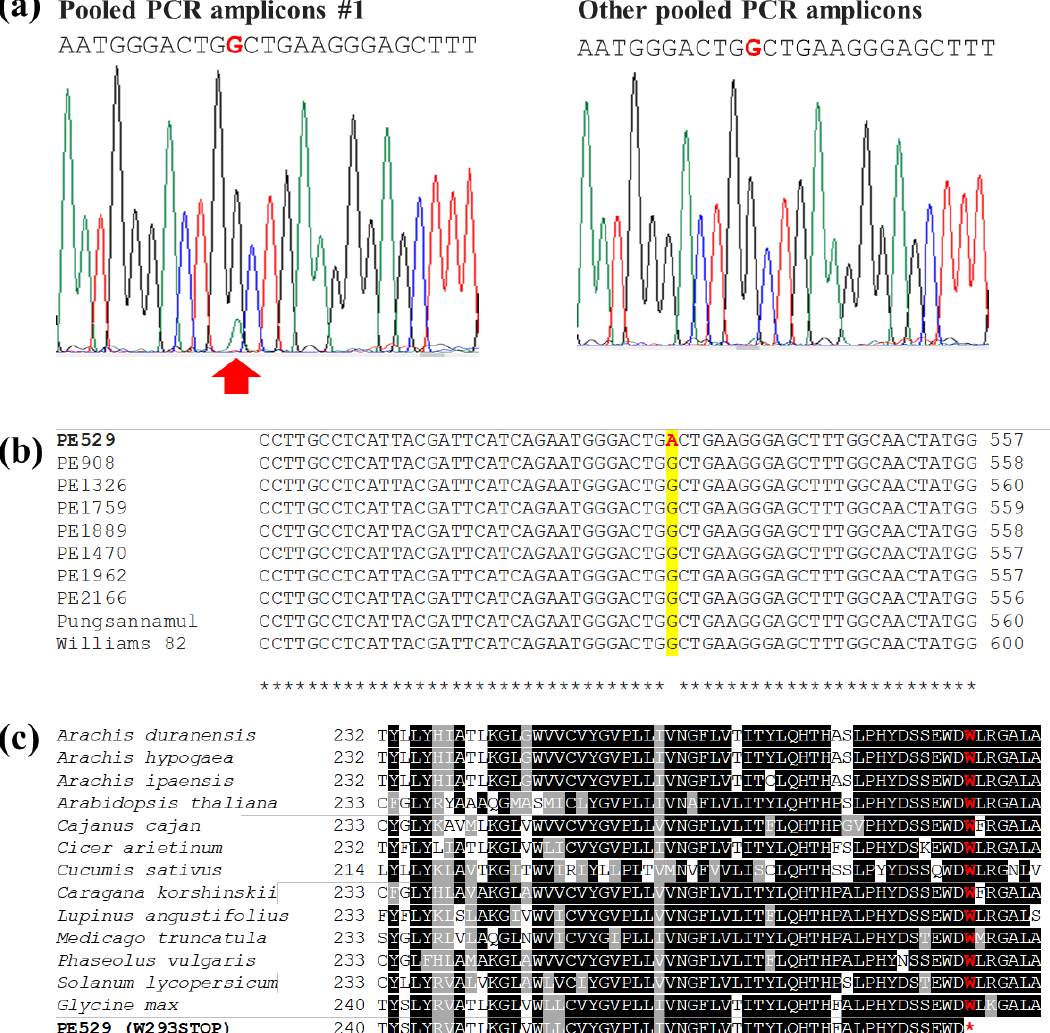
Figure 1. Characterization of mutant allele of FAD2-1A gene in a soybean mutant line PE529. ( a ) Chromas DNA sequence traces for the pooled PCR amplicons. The peaks correspond to the DNA sequence information from the Sanger sequence analysis. The positions of the DNA sequence change are indicated above the trace by the red highlight. A red arrow indicates a possible novel allele of FAD2-1A gene from one of pooled PCR amplicons ( b ) Multiple alignment of FAD2-1A genes. ClustalW sequence alignment of part of FAD2-1A gene with 8 mutant lines, Pungsannamul, and Williams 82 which confirm the new SNP position. ( c ) Multiple alignment of FAD2-1A genes in different plant species. Identical amino acid position is highlighted in black, and position of amino acid change is indicated as red